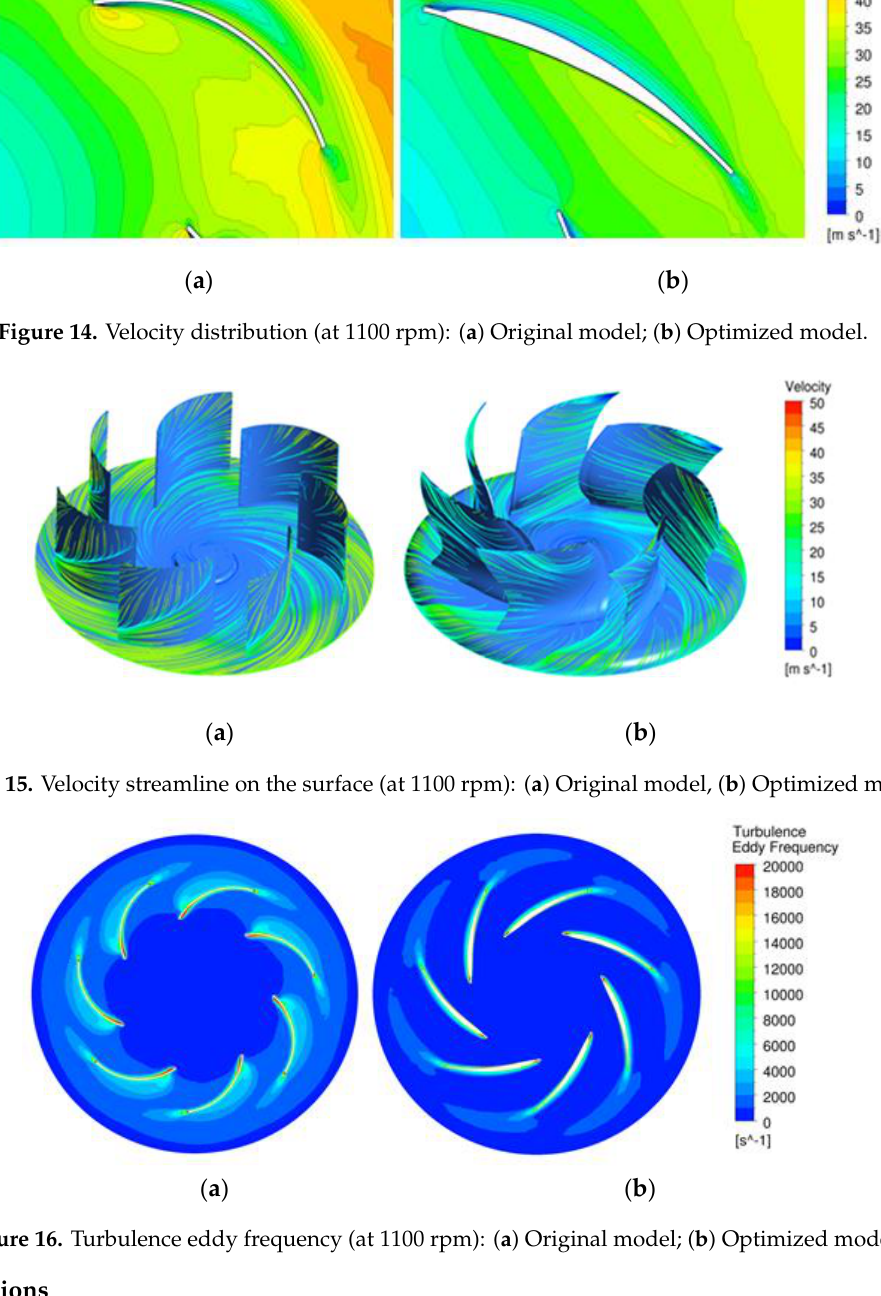
Figure 14. Velocity distribution (at 1100 rpm): ( a ) Original model; ( b ) Optimized model.